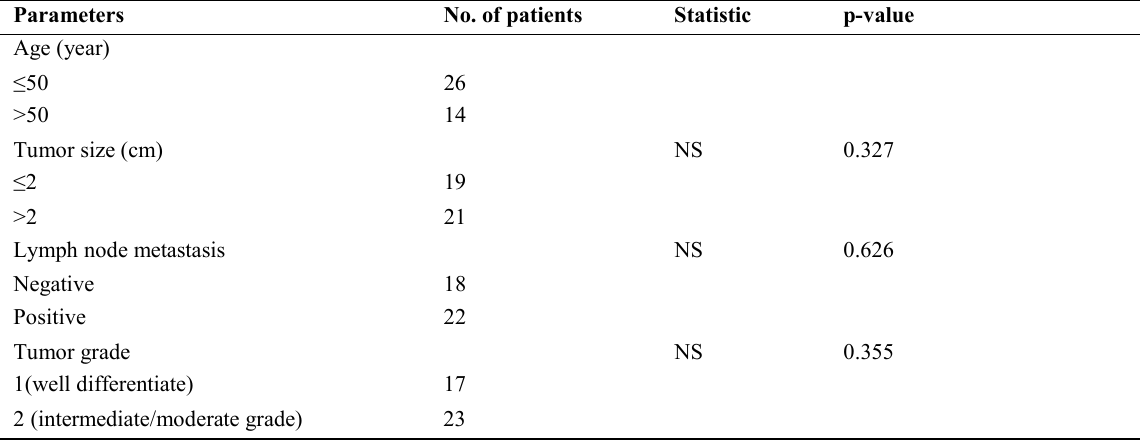
Table 1 . miR-4270 expression and clinico-pathological characteristics of patients with breast cancer